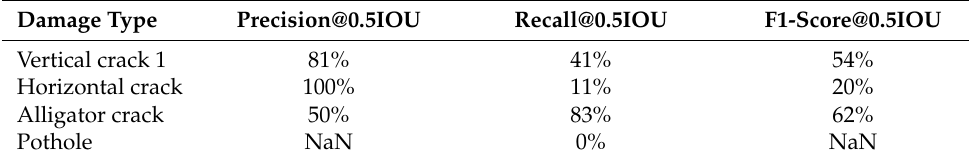
Table 10. Precision and recall Model